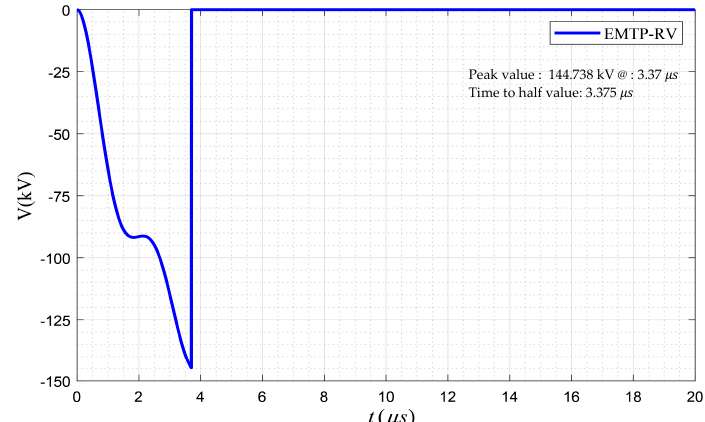
Figure 17. Applied impulse 110 kV in the presence of 500 μH filtered spark gap, EMTP-RV model.